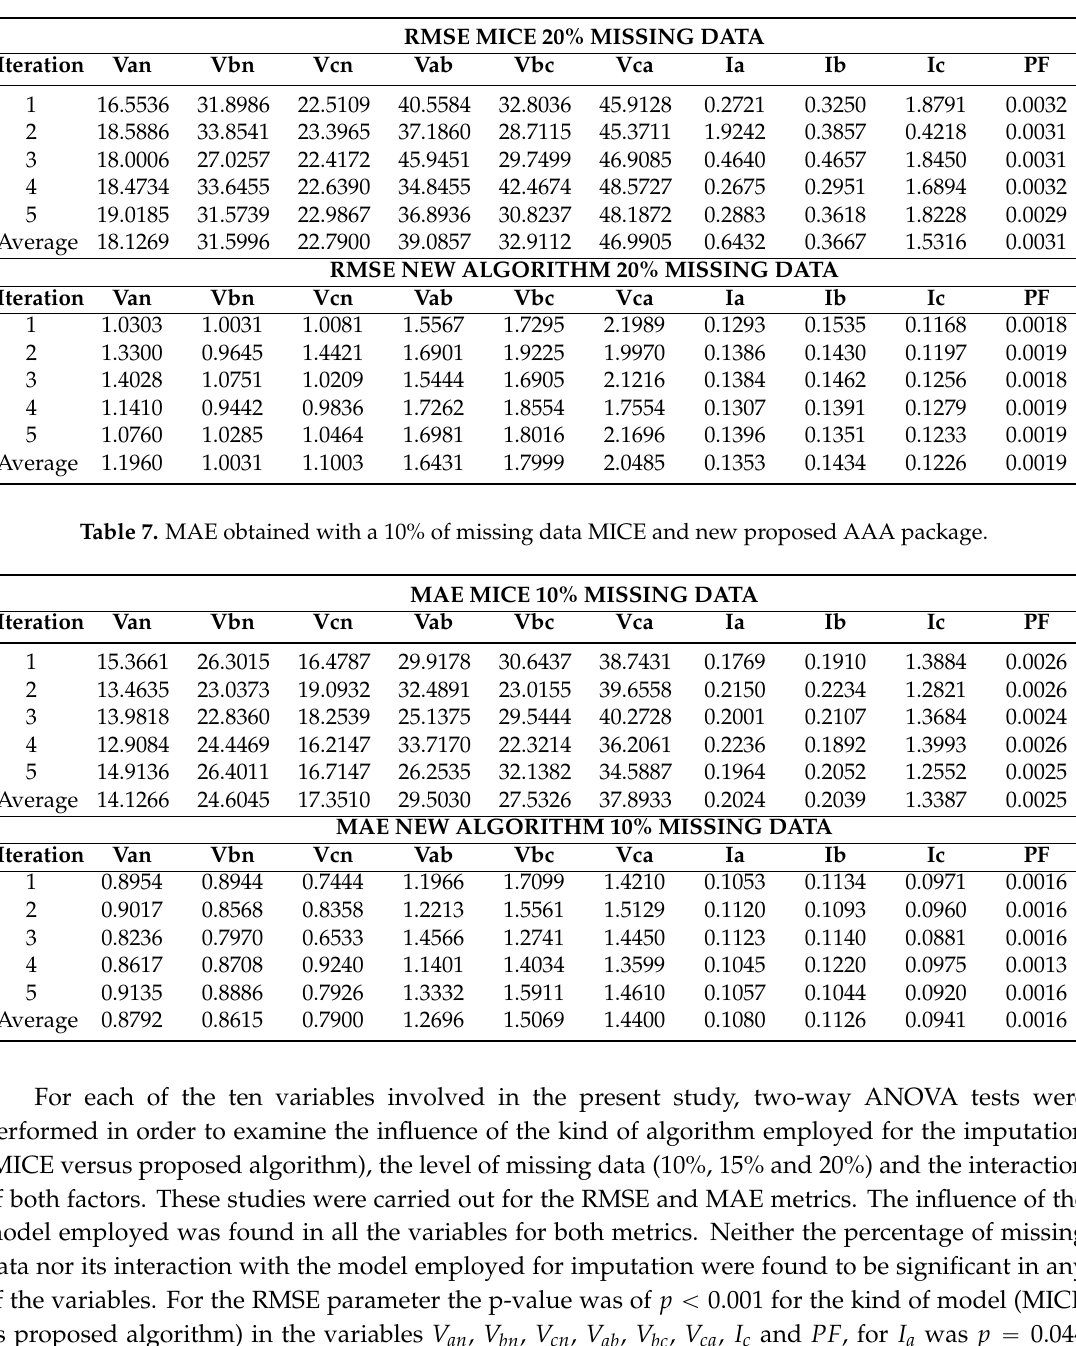
Table 6. RMSE obtained with a 20% of missing data MICE and new proposed AAA package.